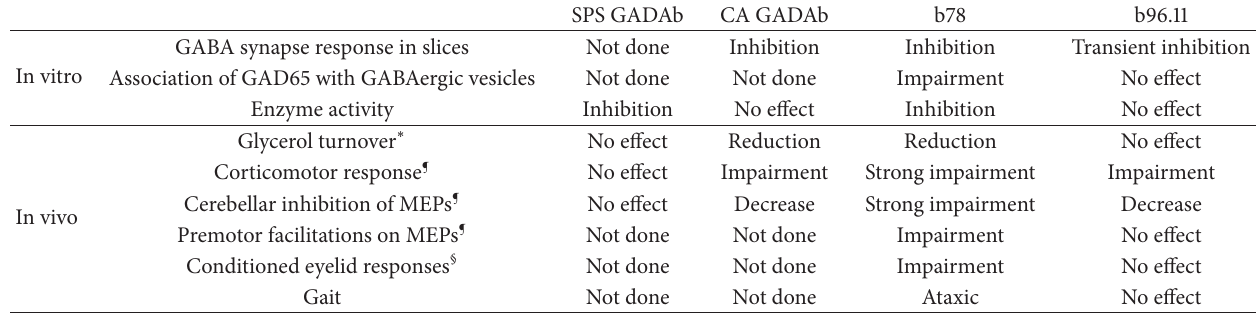
Table 1: Summary of effects of polyclonal and monoclonal GAD65Ab in vitro and in vivo.